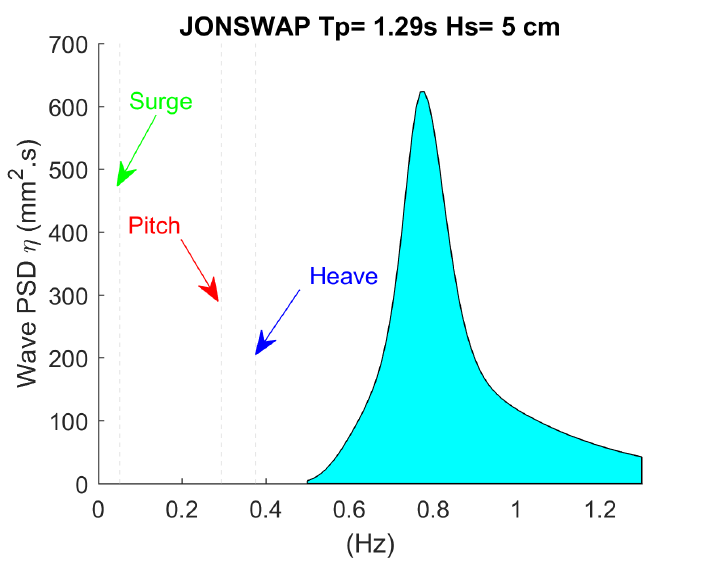
Figure 1. Theoretical JONSWAP spectrum T p = 1.29 s, H s = 5 cm and the eigen frequencies for surge, heave, and